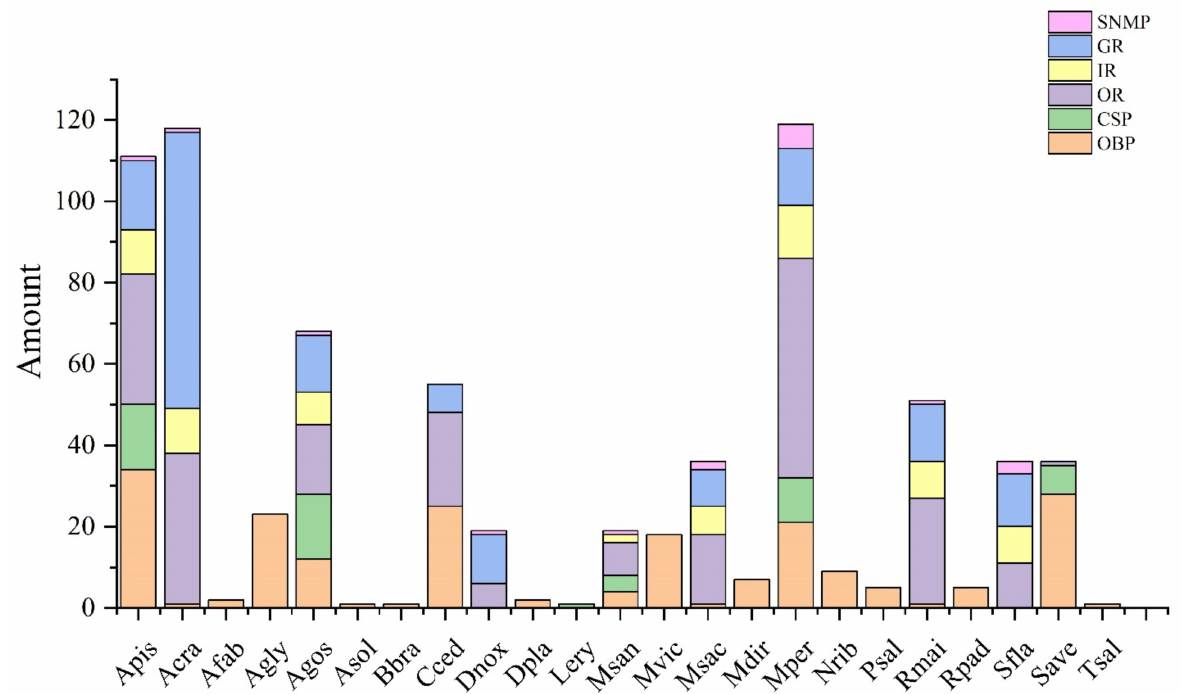
Figure 10. Overview of the identified chemosensory genes of 23 aphid species. Apis: Ac. pisum ; Acra: A. craccivora ; Afab: A. fabae ; Agly: A. glycines ; Agos: A. gossypii ; Asol: Aulacorthum solani ; Bbra: B. brassicae ; Cced: Cinara cedri ; Dnox: D. noxia ; Dpla: Dr. platanoidis ; Lery: L. erysimi ; Msan: M. sanborni ; Mvic: Meg. viciae ; Msac: Mel. sacchari ; Mdir: Met. dirhodum ; Mper: My. persicae ; Nrib: N. ribisnigri ; Psal: P. salicis ; Rmai: R. maidis ; Rpad: R. padi ; Sfla: Si. flava ; Save: S. avenae ; Tsal: T. salignus